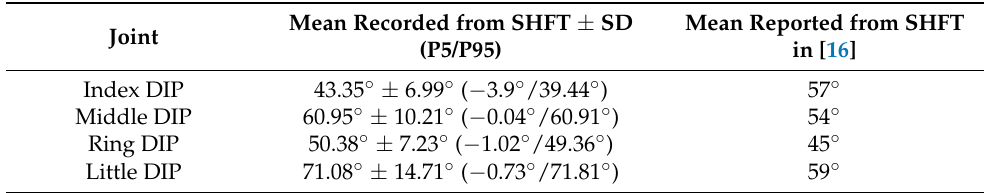
Table 1. Recorded DIP joints for FROM during the Sollerman Hand Function Test (SHFT) of subjects’ dominant hand vs. the reported values in the